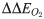
Collapsed phylogenetic tree of trHbs annotated with their key physicochemical characteristics.The circular phylogram shows the topology derived from Fig 2A, with color-matched boxes indicating hierarchical clustering. ΔΔEO2 values are mapped on the inner concentric circle using a violet color gradient (greater stabilization, darker violet). Tunnel apertures are mapped as red, cyan and light green dots for Long Tunnel, Short Tunnel G8 and E7 Gate, respectively, on the other concentric circles. Dot size indicates tunnel openness.